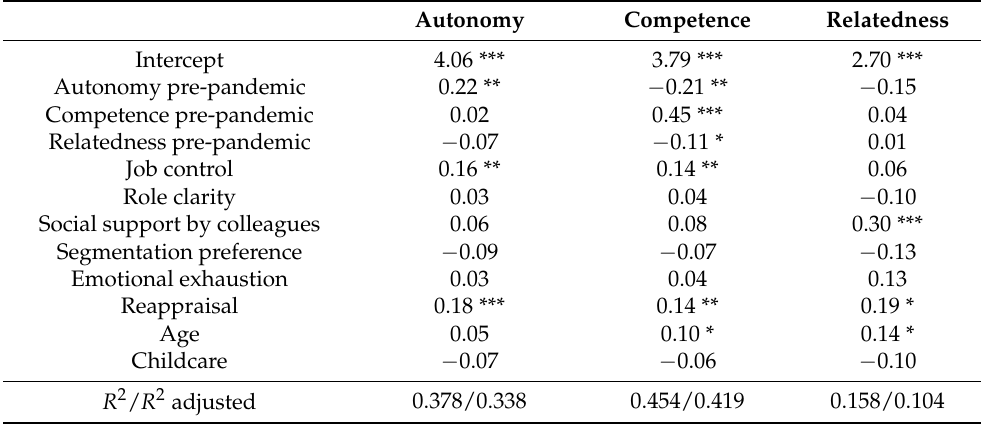
Table 4. Linear regression models regressing background variables onto satisfaction of each need when working from